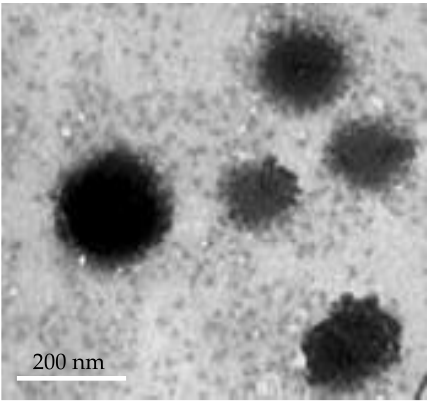
Figure 4. Transmission electron imaging of optimized VDF-loaded bilosomal formulation.